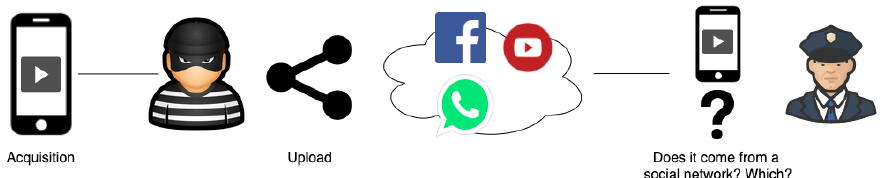
Figure 1. An application example of the proposed solution. An attacker records a video with illegal content and shares it on social networks or messaging apps. Subsequently, the police seize a device with this video and want to trace the